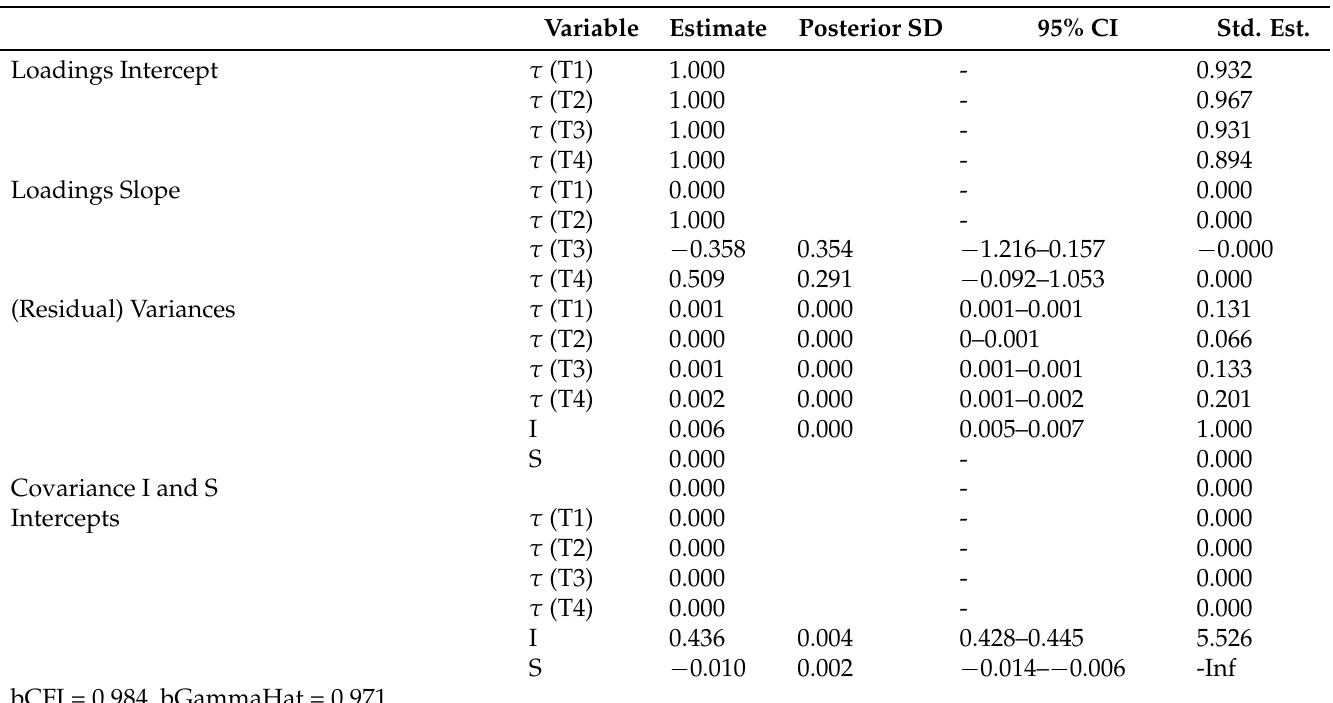
Table 5. Parameter estimates and model fit of the non-decision time growth curve